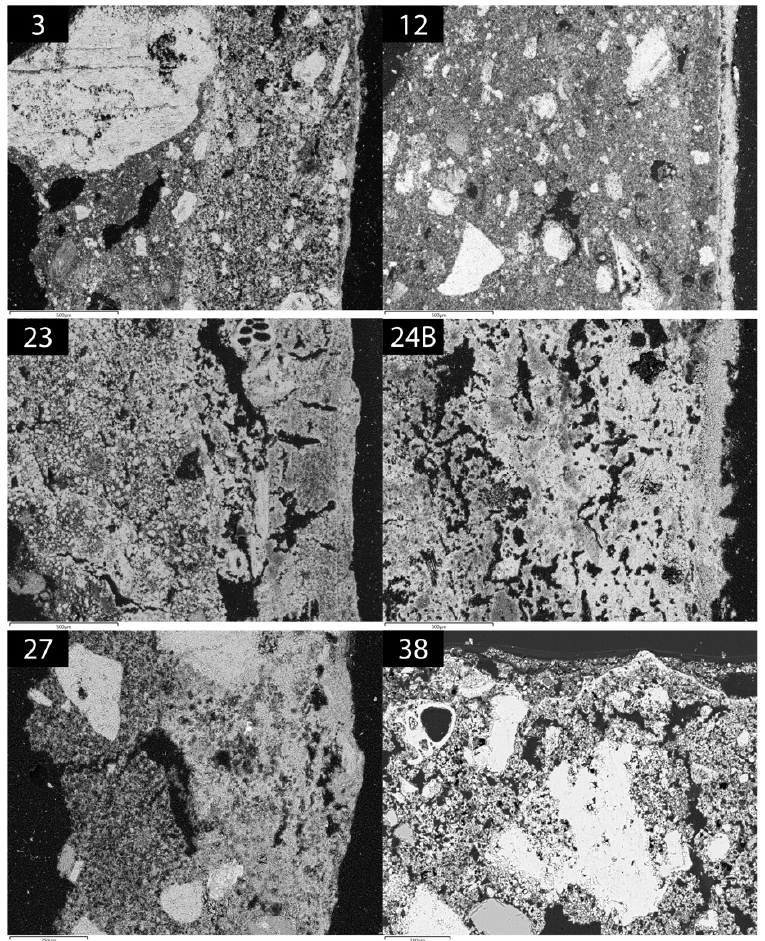
Figure 2. SEM-BSE photomicrographs of thin sections of analysed